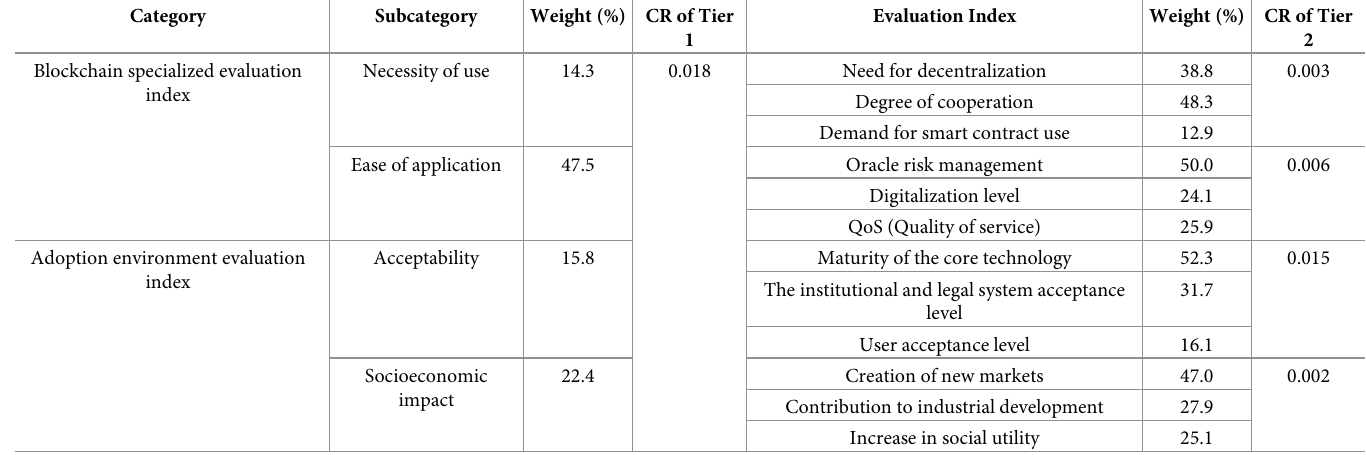
Table 6. AHP result for the weights of evaluation